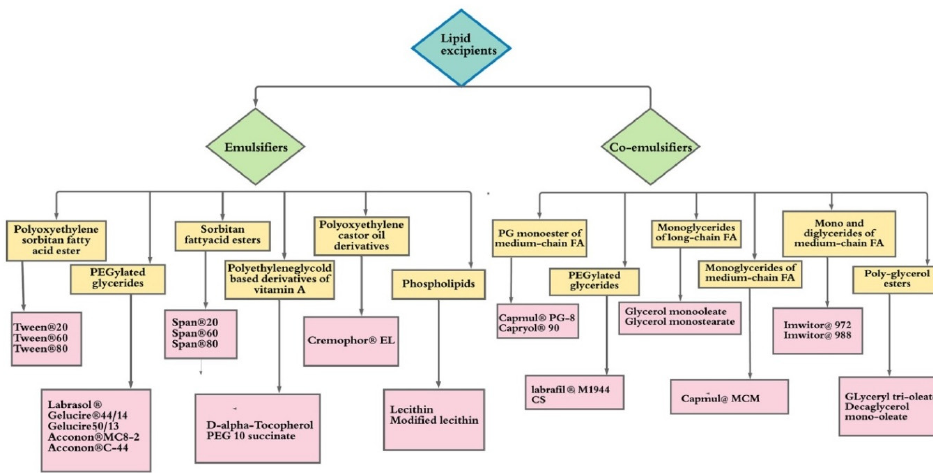
Scheme 1. Classification of commercially available lipid excipients. Table 1. List of lipid excipients used in the pharmaceutical product development USFDA IID- United States of Food and drug administration inactive ingredient database, USP—United States Pharmacopeia, NF—National formulary, DMF—Drug master file.